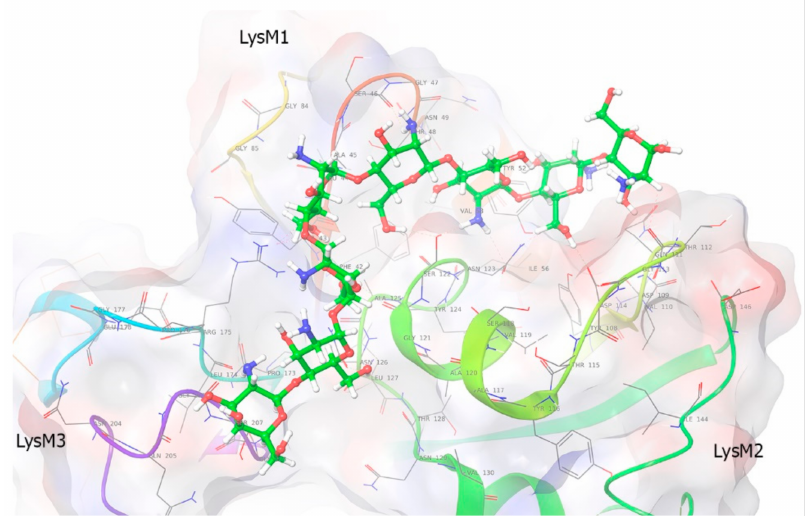
Figure 7. Molecular modeling of PsLYK9-ECD binding with CO8-DA. The main ligand conforma- tion pattern is partly placed at the groove between LysM1 and LisM2 (four upper ligand rings), approaching LysM2, whereas the rest of the ligand descends to the central groove between LysM3 and LysM2. The type of binding is partly hydrophobic (at the area of LysM2 domain) and partly polar at the side of binding between LysM2 and LysM3. The lower and upper CO8-DA molecular rings are half-available to the